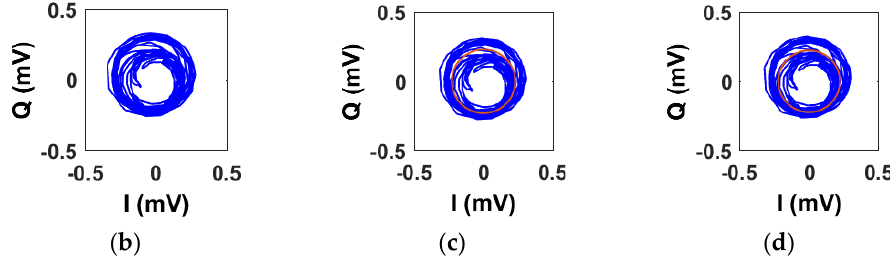
Figure 7. Example of baseband signals in the IQ plane obtained with the sub-10 GHz radar after applying the DC calibration methods. ( a ) Spectra obtained from the retrieved respiration signals. ( b ) Spectra obtained from the retrieved heartbeat signals.